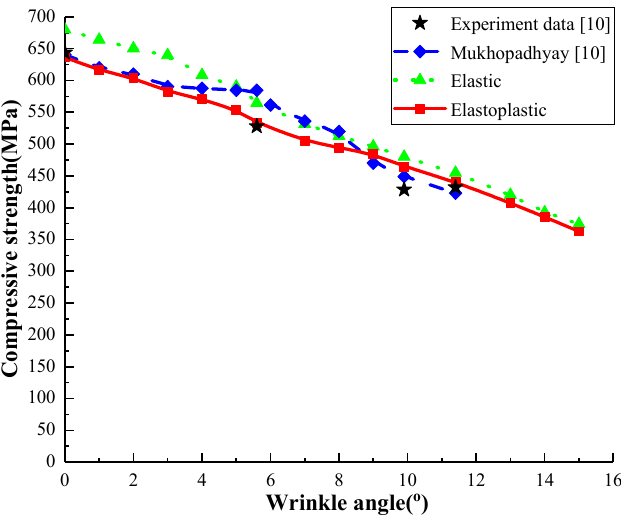
Figure 14. Wrinkle severity versus compressive strength.